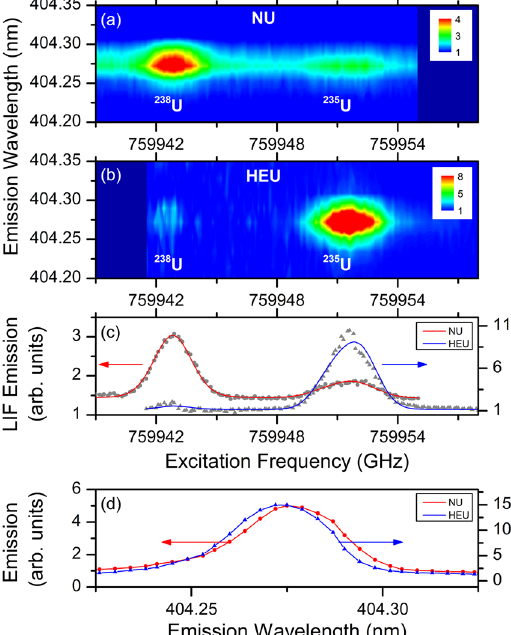
Figure 2. 2DFS of natural (NU) and highly-enriched (HEU) uranium samples in 50 Torr Ar. ( a ) 2DFS intensity for NU sample. ( b ) 2DFS for HEU sample. The ECDL scan ranges were slightly offset for ( a , b ) and the darker blue represents regions outside the scan range. ( c ) LIF excitation spectrum for NU (red) and HEU (blue) samples. Solid lines show fits to spectra using model described in text. ( d ) Emission spectrum of the U I 404.28 nm transition for NU (red) and HEU (blue) samples with ECDL resonant with the 238 U I 394.38 nm and 235 U I 394.38 nm transition, respectively. A small blue shift of the 235 U emission is